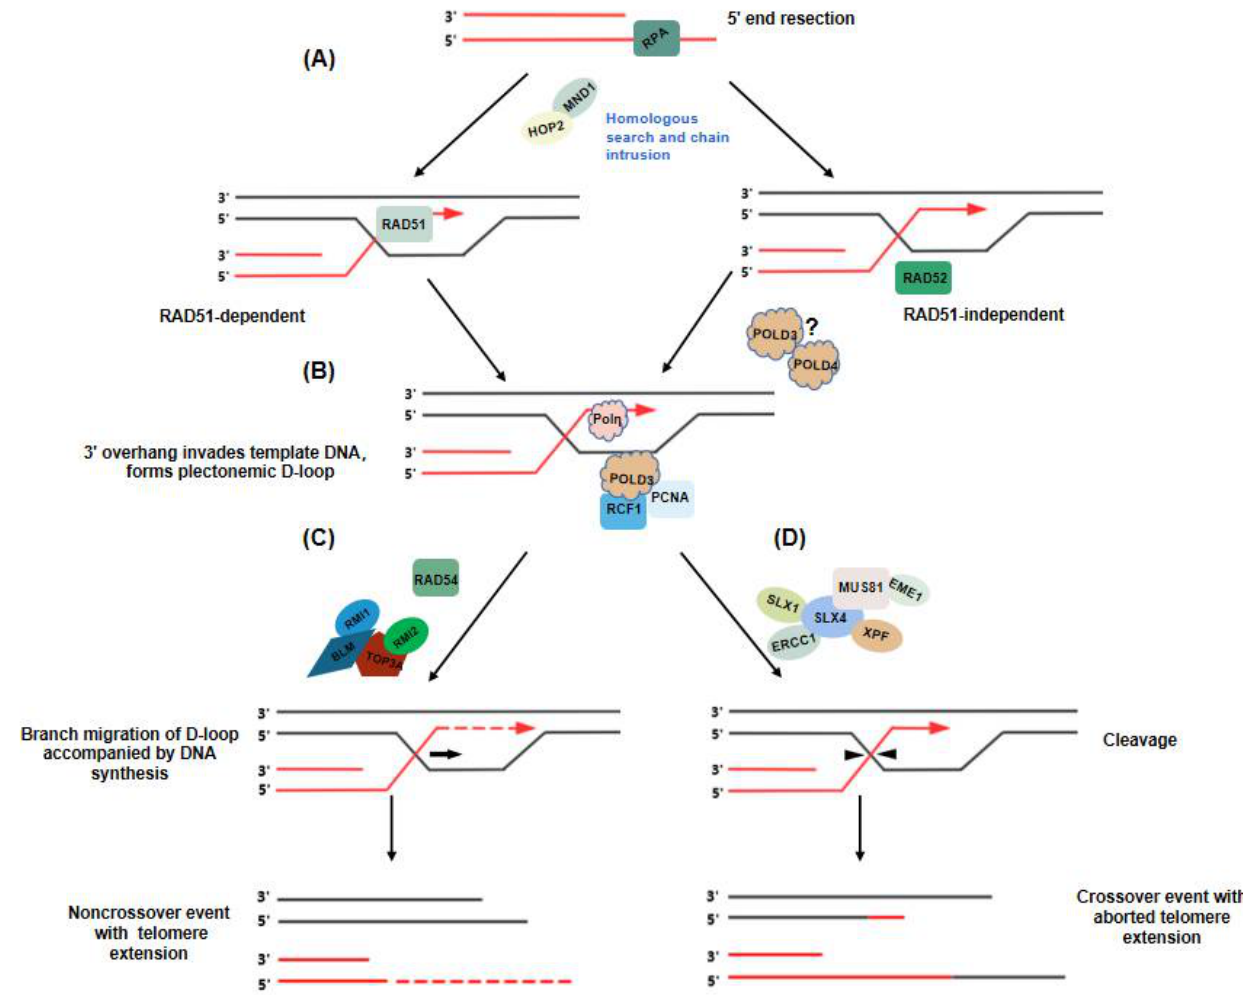
Figure 4. D-loop migration and unraveling of recombinant intermediates. ( A ) Homologous search and chain invasion mediated by HOP2–MND1. ( B ) Telomeric DNA synthesis, promoted by DNA polymerase. ( C ) D-loop migration, promoted by RAD54. RAD54 may function in coordination with BLM to promote BTR complex-dependent dissolution of recombination intermediates. (D) Intermediates unraveling can also be achieved through SMX complex recruitment, leading to telomere exchange without telomere extension.